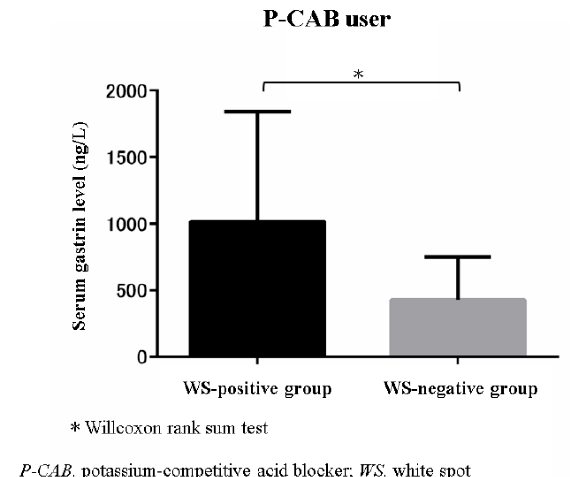
Figure 3. Comparison of the fasting serum gastrin level between the WS-positive and WS-negative groups within the group of patients using P-CAB: * p < 0.05; Wilcoxon rank-sum test; WS, white spot; P-CAB, potassium-competitive acid blocker.